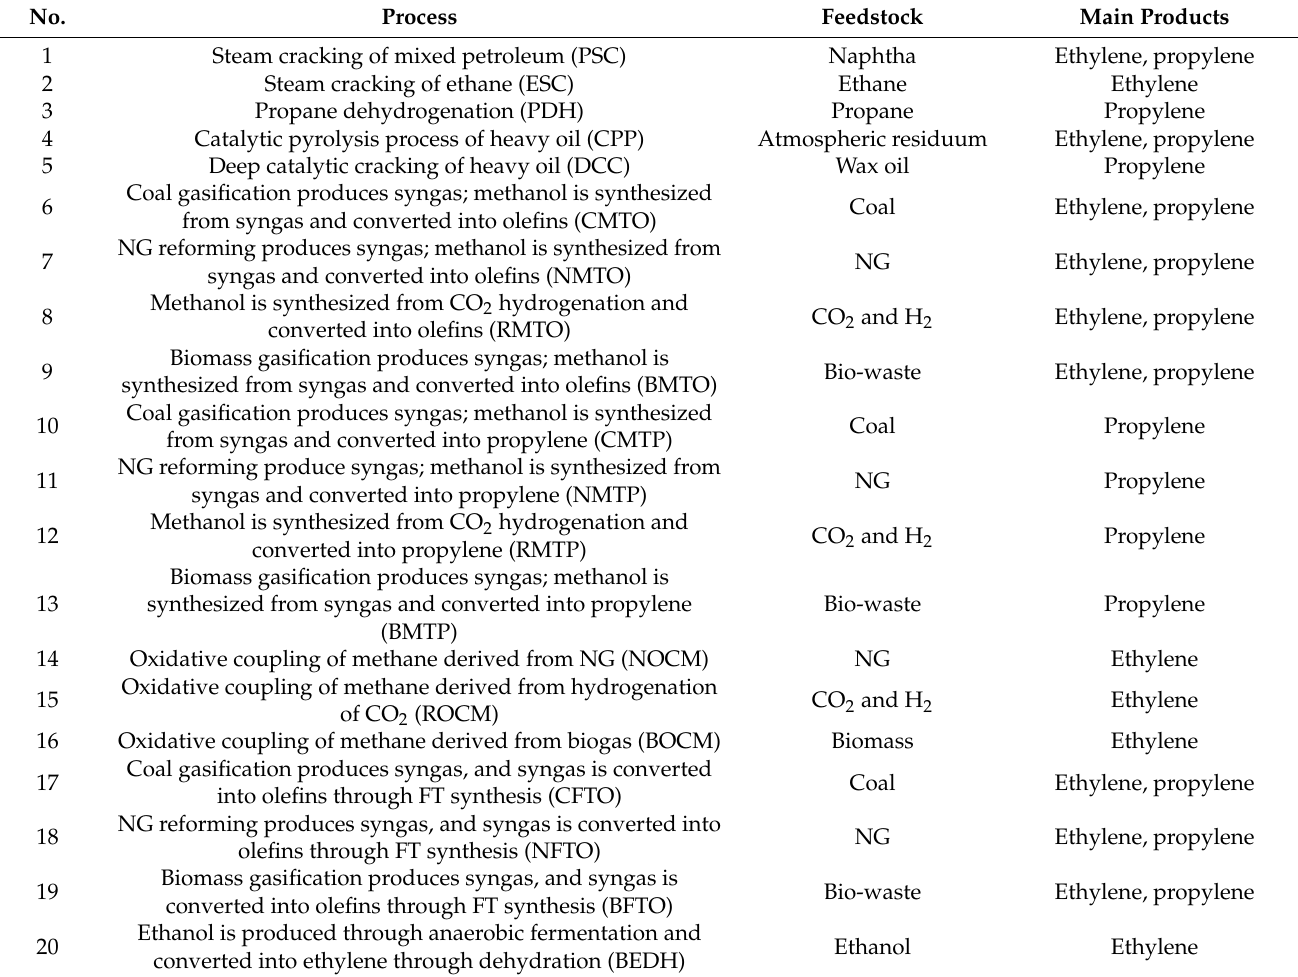
Table 1. Description and attributes of conversion pathways